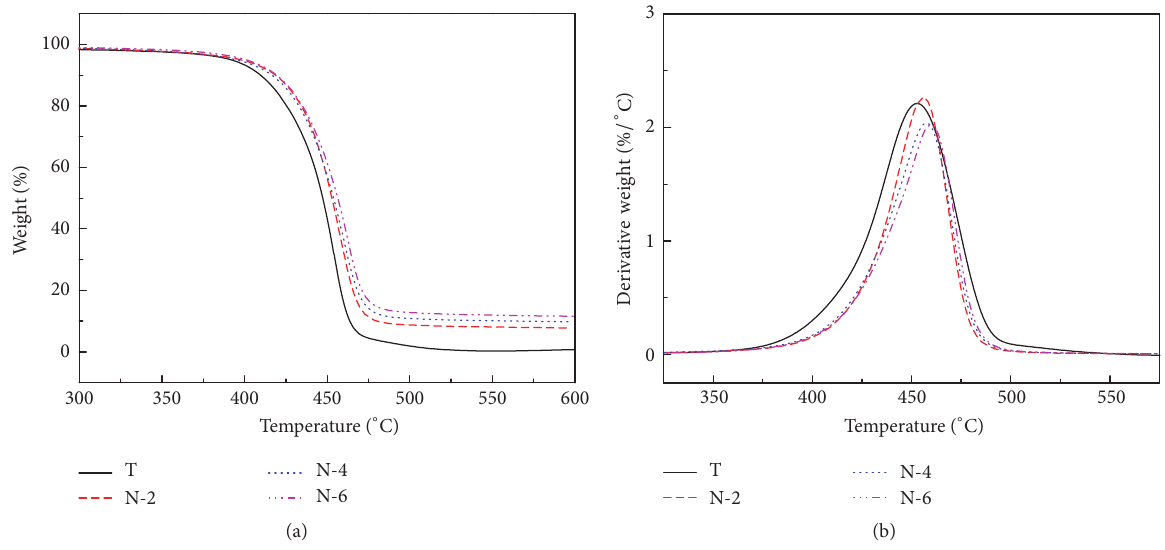
Figure 9: (a) TGA decomposition and (b) derivative TGA curves of PPO/PA66 blends and nanocomposites.